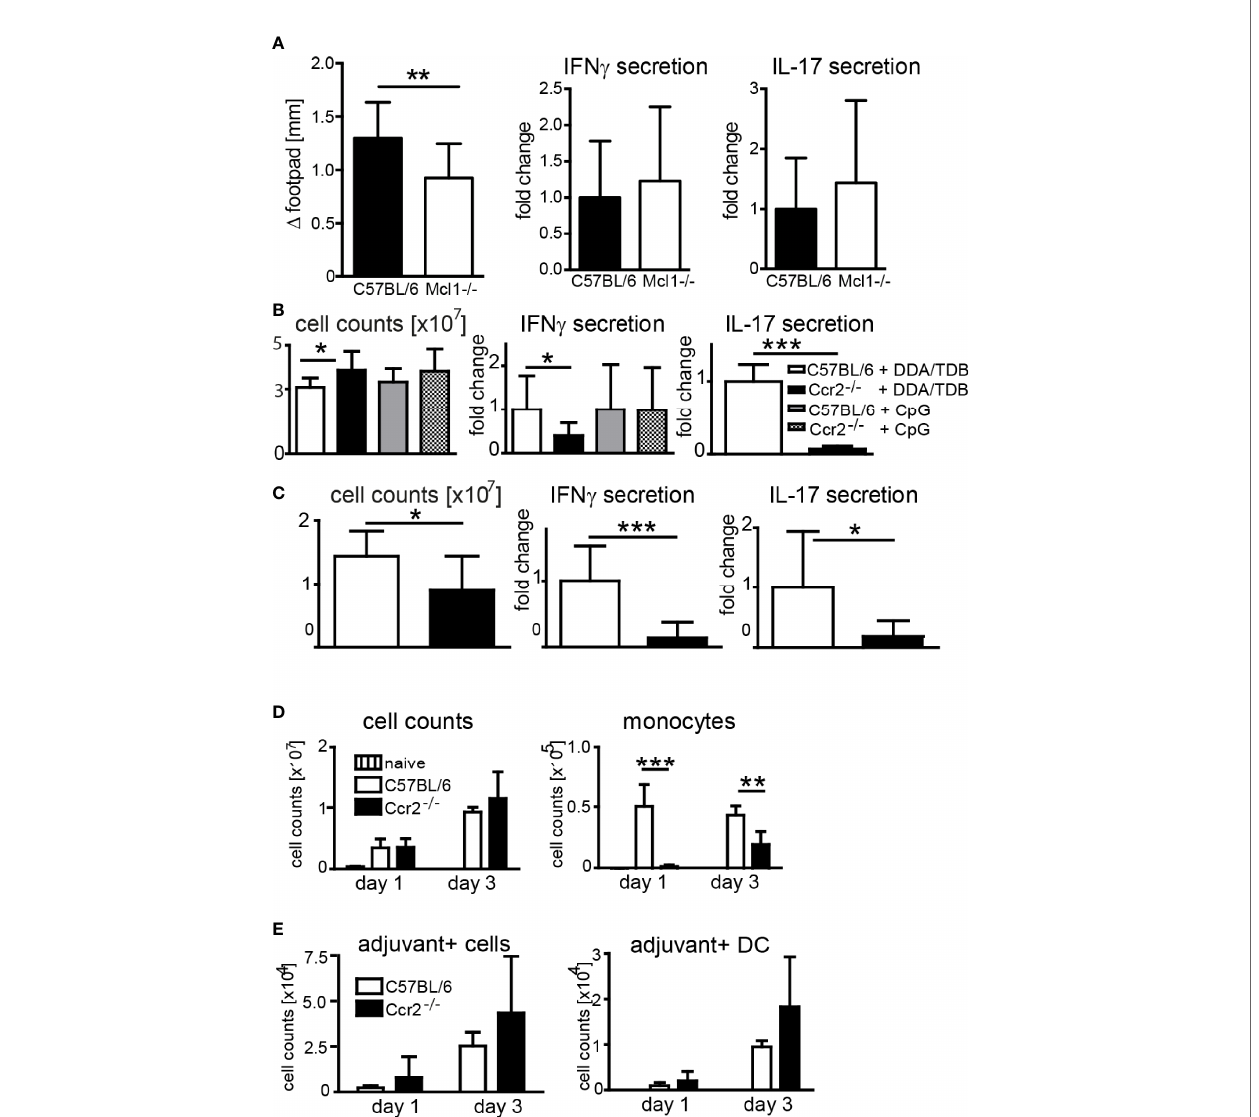
FIGURE 4 | Effect of genetic depletion of neutrophils or CCR2 on adjuvanticity of DDA/TDB. (A) Footpad swelling and IFN g and IL-17 secretion from popliteal lymph nodes of Mcl1 -de fi cient and Mcl1 +/+ ; LysM-Cre + control mice 7 days after DDA/TDB/H1 s.c. footpad immunization. N=7/9, pooled from two independent experiments. (B, C) Cell counts, IFN g , and IL-17 secretion from pooled popliteal and inguinal lymph nodes of C57BL/6 or Ccr2 − / − mice (B) 7 days post footpad or (C) 28 days post s.c. base of tail immunization (2´ 14-day interval). Pooled data from two independent experiments each with a total of n=10 mice per group. Cytokine secretion normalized to immunized control mice; all data presented as mean+SD. Signi fi cance tested by t-test; *p < 0.05 and ***p < 0.001. (D) Numbers of total cells and monocytes and (E) of adjuvant + total cells and DC, in popliteal lymph nodes 1 and 3 days p.i., s.c. footpad immunization with NBD-DDA/TDB. Pooled data from two independent experiments with a total of fi ve to six mice per group/time point. All data presented as mean+SD. Signi fi cance tested by one-way ANOVA and Dunnett ’ s post-test with immunized C57BL/6 as control group; *p < 0.05, **p < 0.01, and ***p < 0.001. For gating, see Supplementary Figure S1